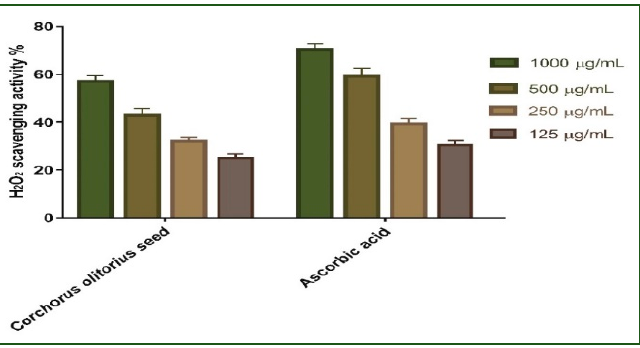
Figure 1. H 2 O 2 radical scavenging activity of Corchorus olitorius seed extract at different concentra- tions (1000, 500, 250, and 125 µg/mL). Bars represent mean ± standard deviation (SD). Significant difference between groups is analyzed by a two-way ANOVA test after normalization of variables by the Shapiro–Wilk test.